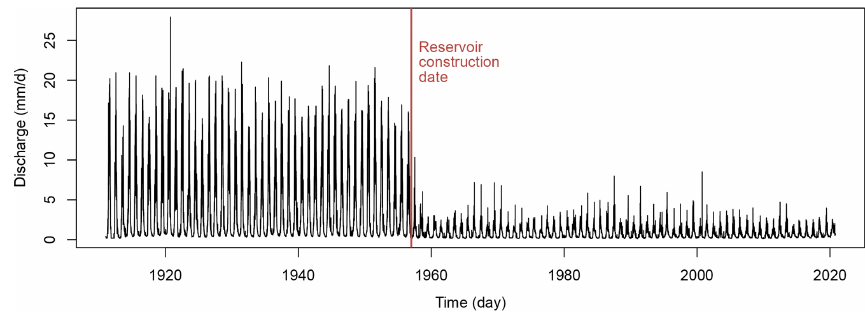
Figure 2. Streamflow time series for the catchment of the Dranse de Bagnes (gauge Le Châble) illustrating streamflow changes induced by the construction of the Mauvoisin reservoir in